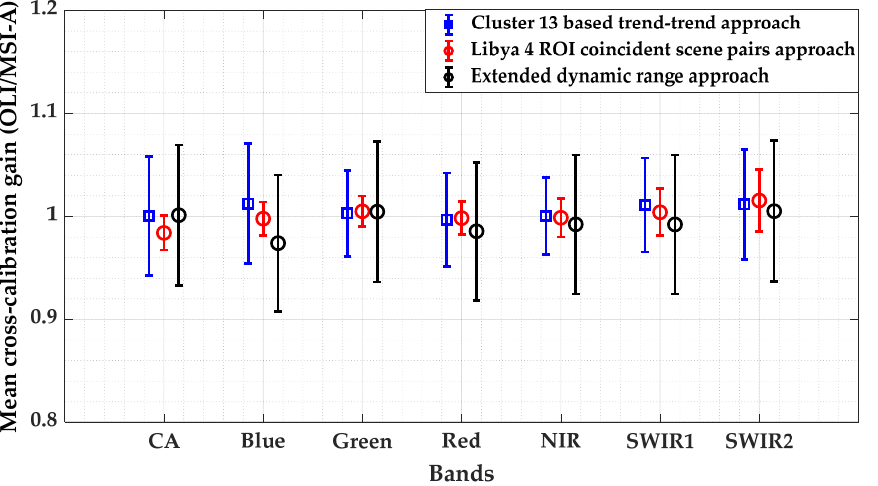
Figure 19. Cross-calibration gains comparison of Landsat 8 OLI and Sentinel 2A MSI using a traditional ROI-based approach and the cluster-based approach. (Blue and black bars represents the uncertainty and the red bar is the associated standard deviation at k = 2).